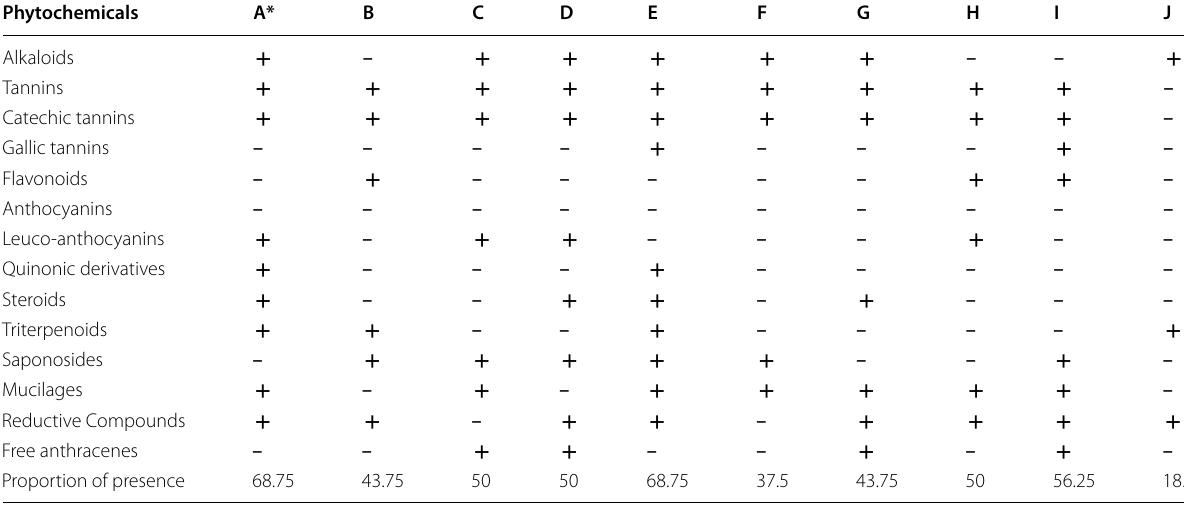
*Legend: means present; – means absent (Omara et al. 2021a). Plant species: A + Fresen.;